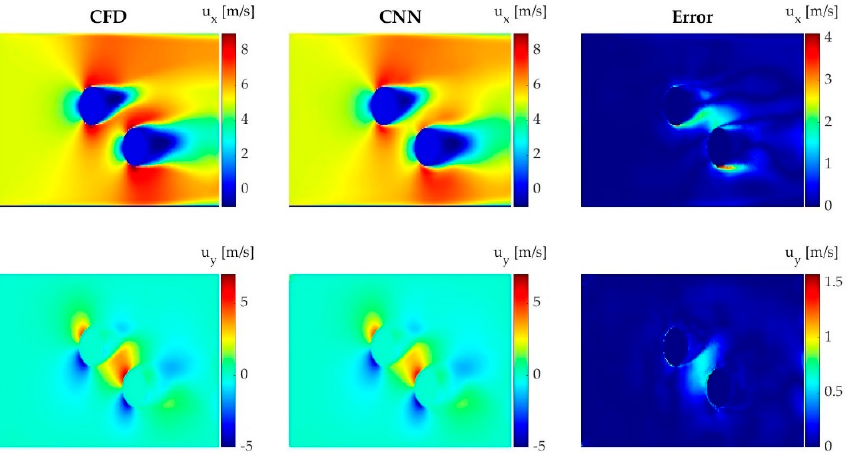
Figure 11. Information about the used domain with multiple geometry. ( a ) Numerical domain; ( b ) FRC layer; ( c ) SDF layer of the geometries (the contour of the geometries is drawn in white); ( d ) SDF layer of the walls.